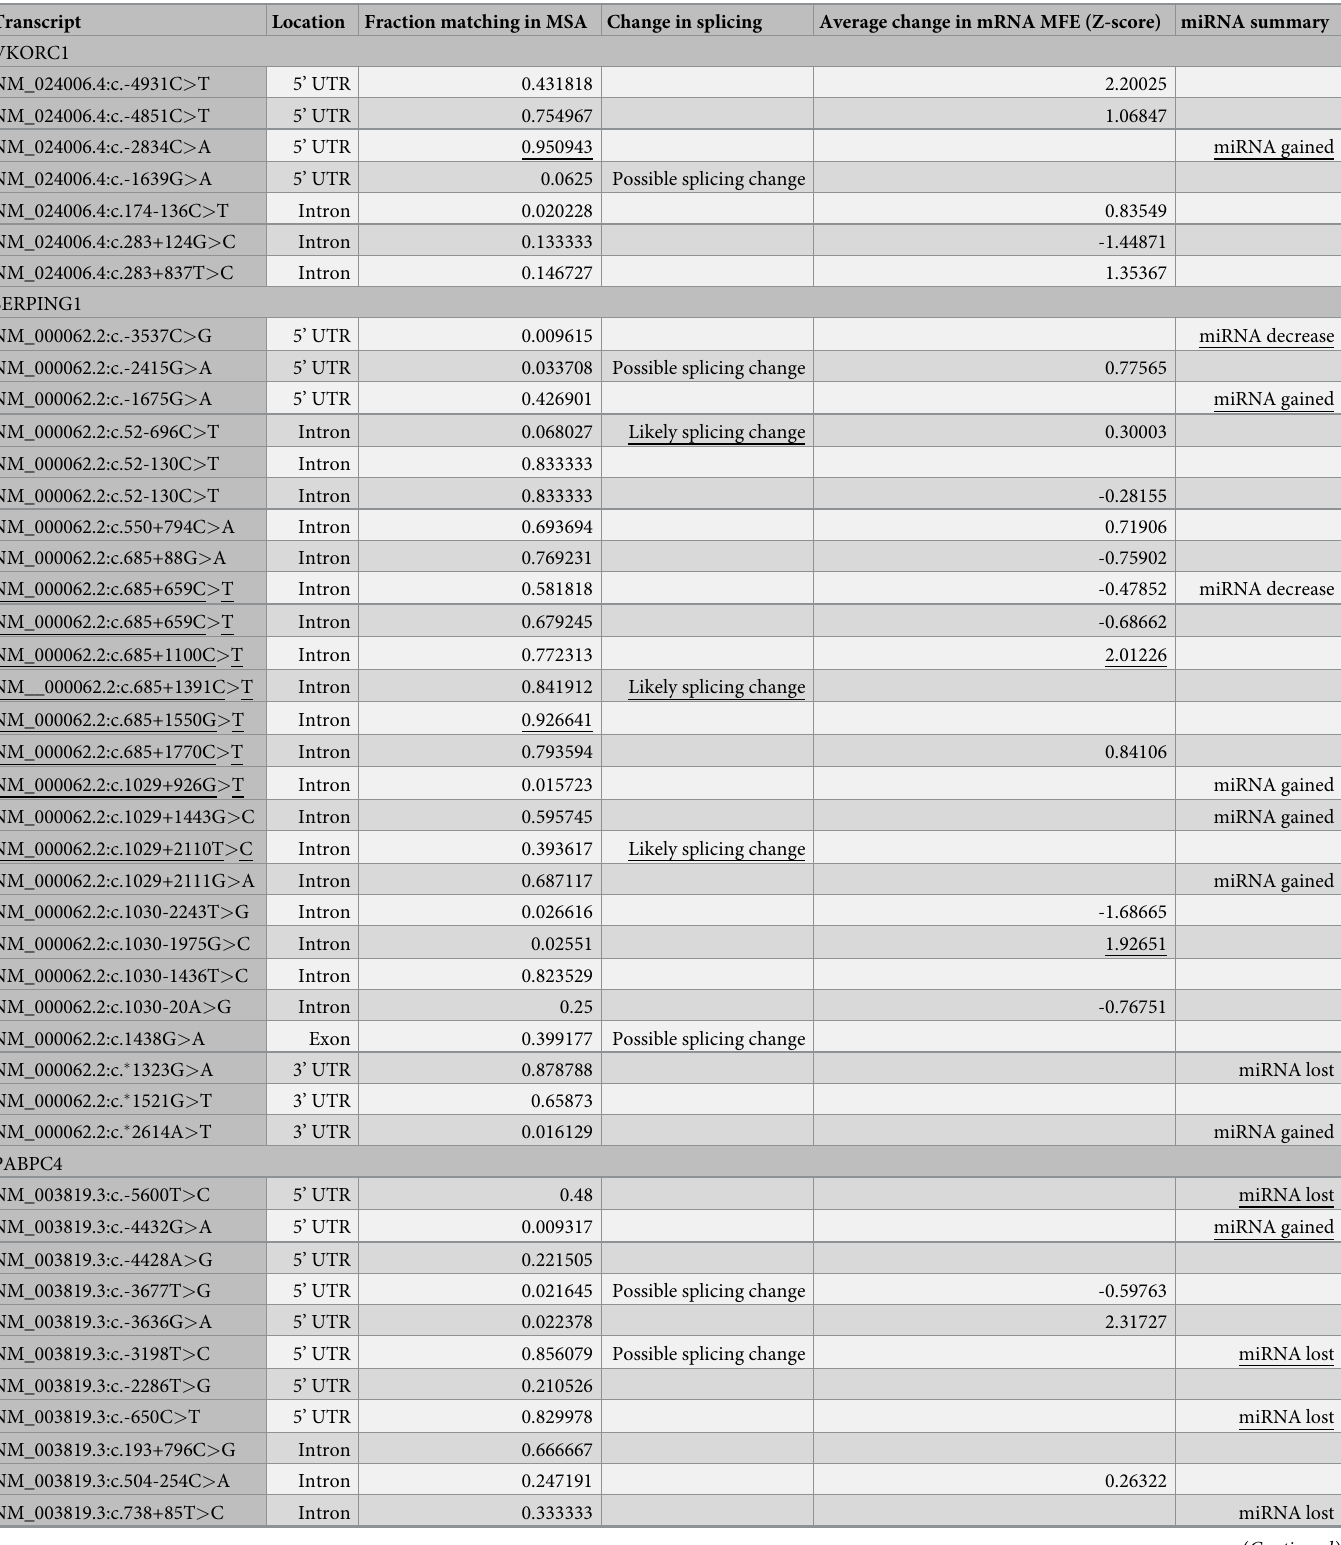
Table 2. Possible predicted effect of variants in VKORC, SERPING1 and